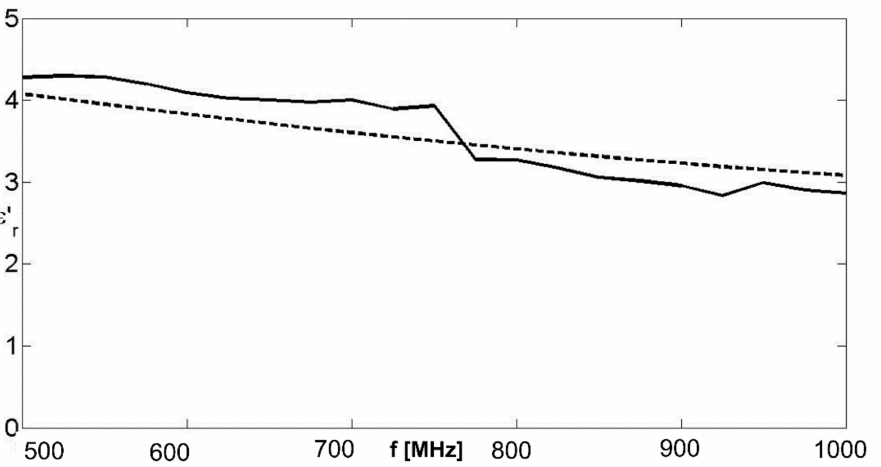
Figure 11. Real part of the equivalent complex permittivity for a Debye dispersion law. Solid line: retrieved value; dashed line: actual value. Noisy data with SNR = 20 dB. Random parametric error on the length of the probe, Gaussian with standard deviation 0.2